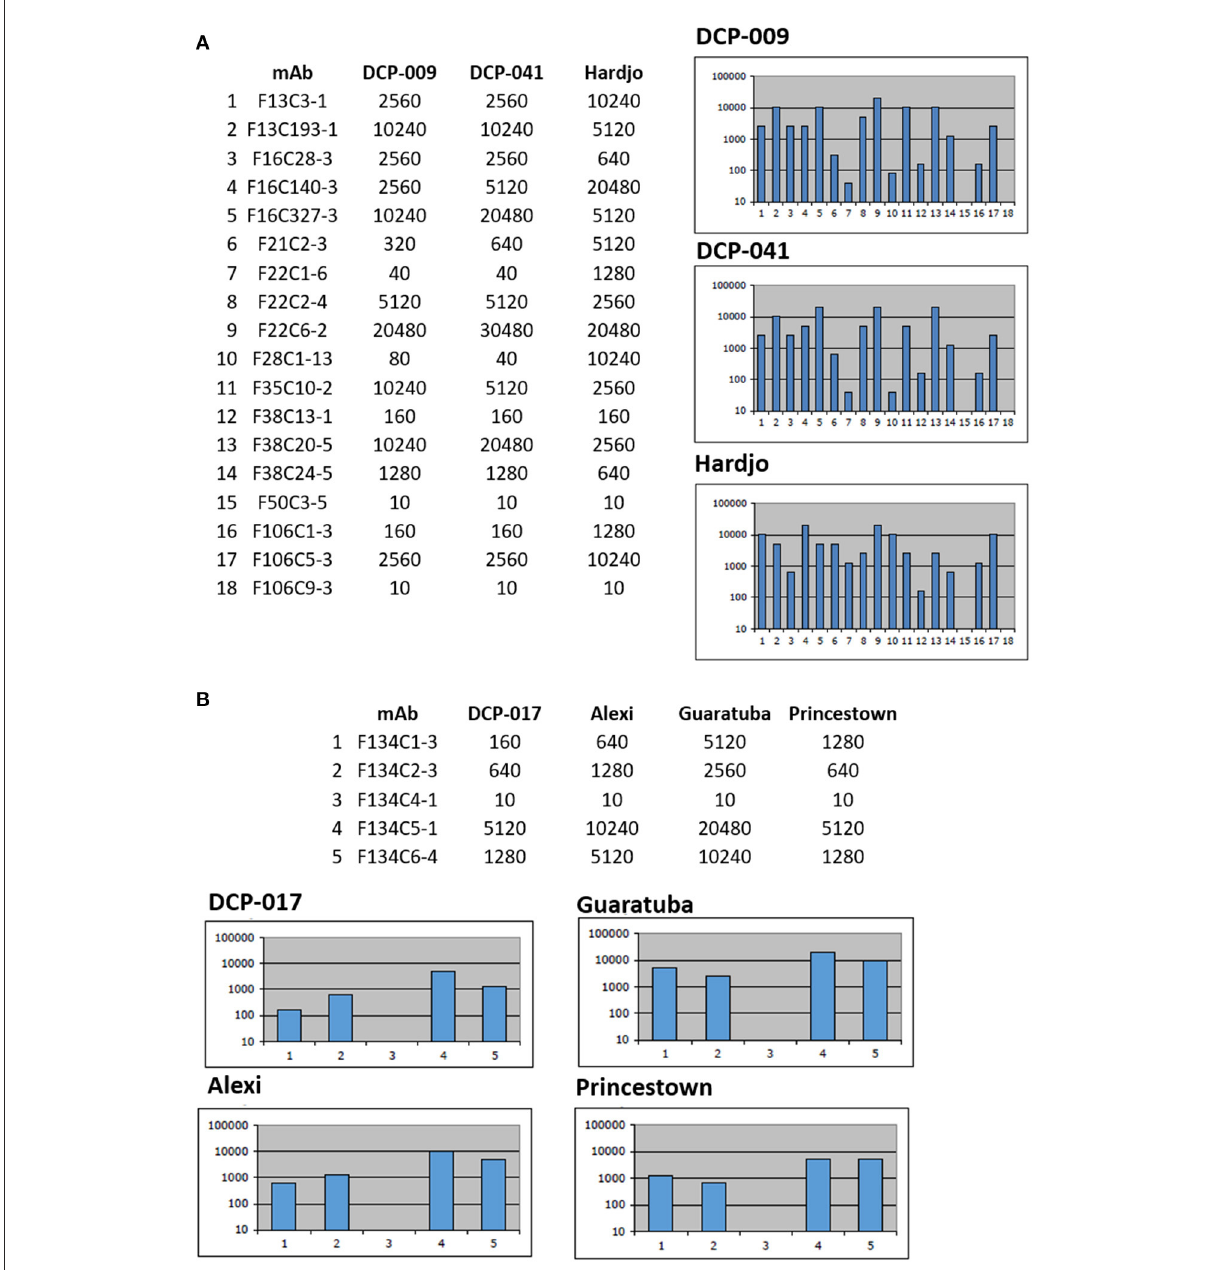
FIGURE1 Serotyping with monoclonal antibodies (mAb) that characteristically agglutinate serovars from the serogroup Sejroe and serogroup Pyrogenes. Titers of reactivity for each mAb are provided for (A) L . borgpetersenii strains DCP-009, DCP-041 and reference strain L . interrogans serogroup Sejroe serovar Hardjo strain Hardjoprajitno and (B) L . santarosai strain DCP-017 and reference strains for serogroup Pyrogenes; L . santarosai serovar Alexi strain HS 616, L . interrogans serovar Guaratuba strain An 775 and L . santarosai serovar Princestown strain TRVL 112499. Reciprocal titers are shown on the y -axis; mAb number is shown on the x -axis.